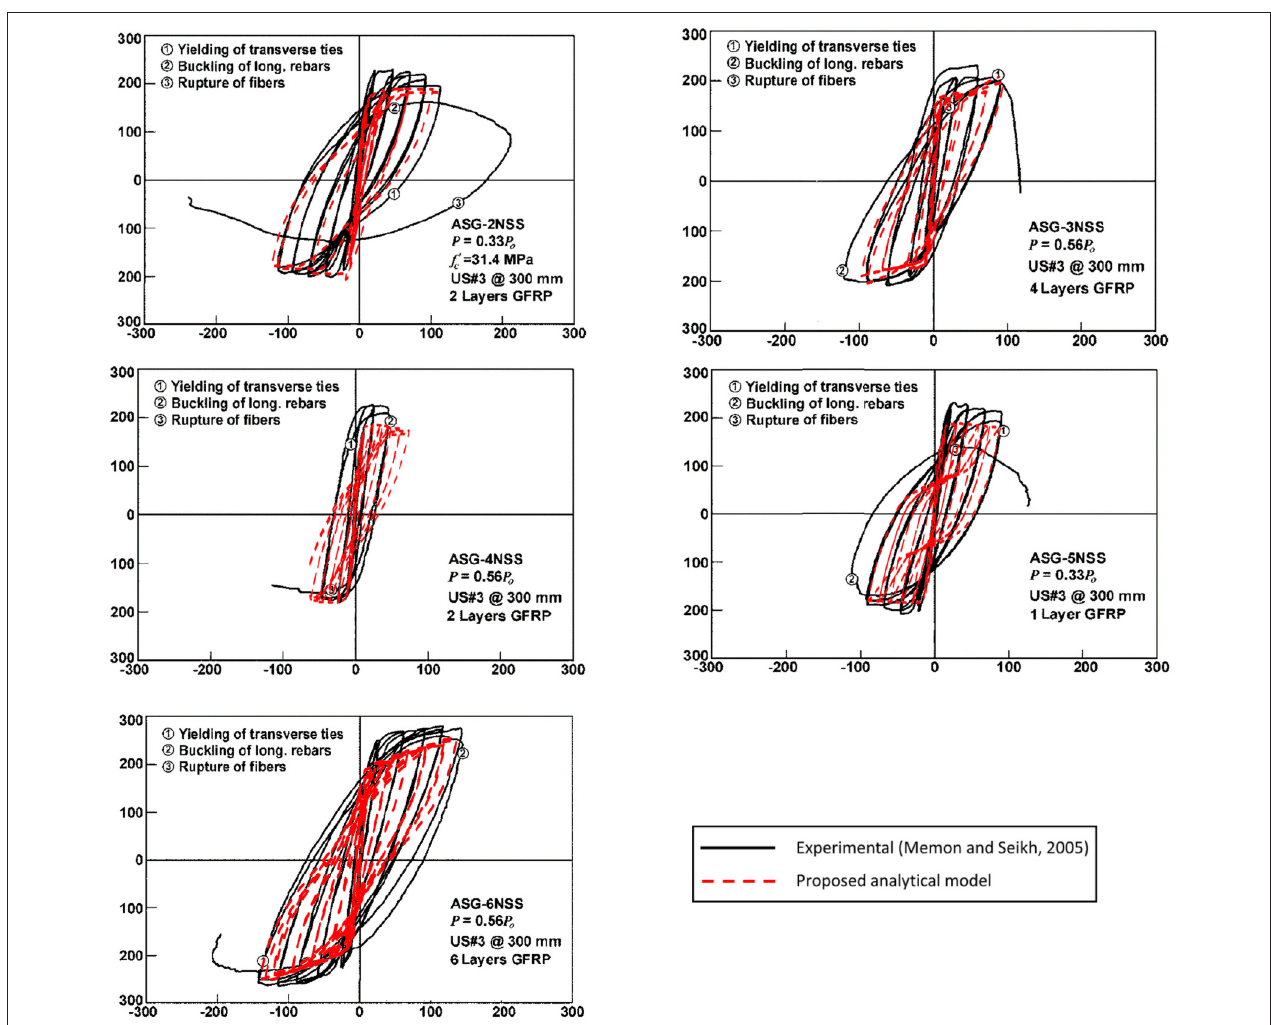
FIGURE 14 | Correlation of the proposed material model with experimental results of large-scale GFRP-confined square RC columns under cyclic excitation by Memon and Sheikh